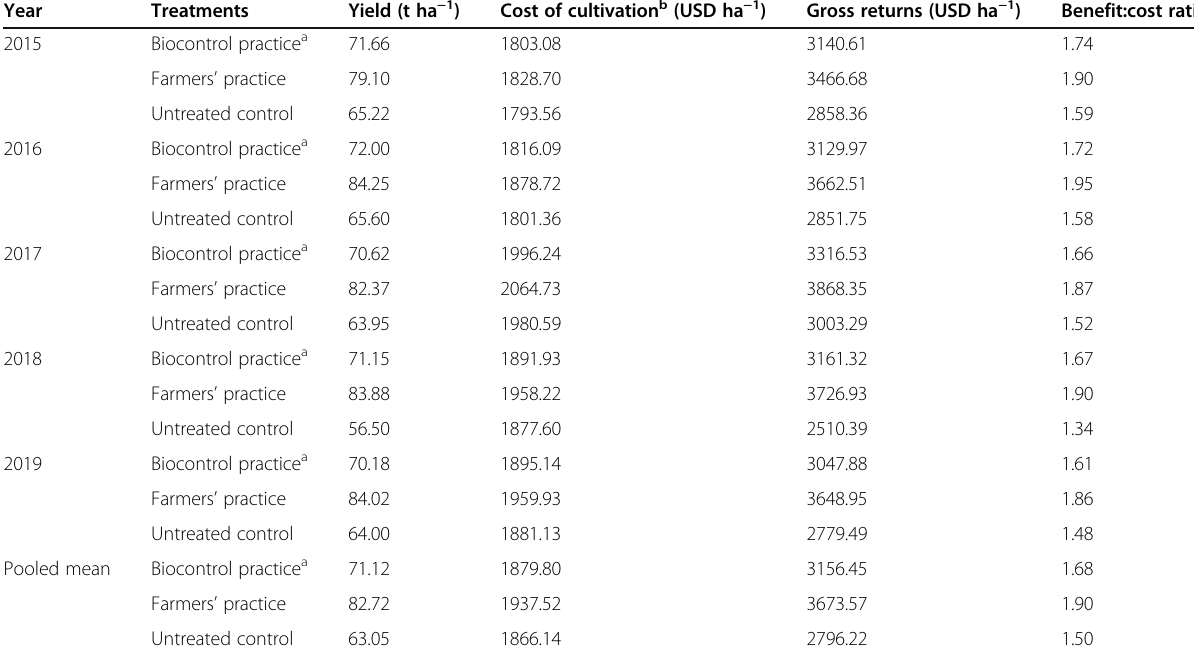
Table 3 Cost of cultivation and economics returns from various treatments in the management of C.